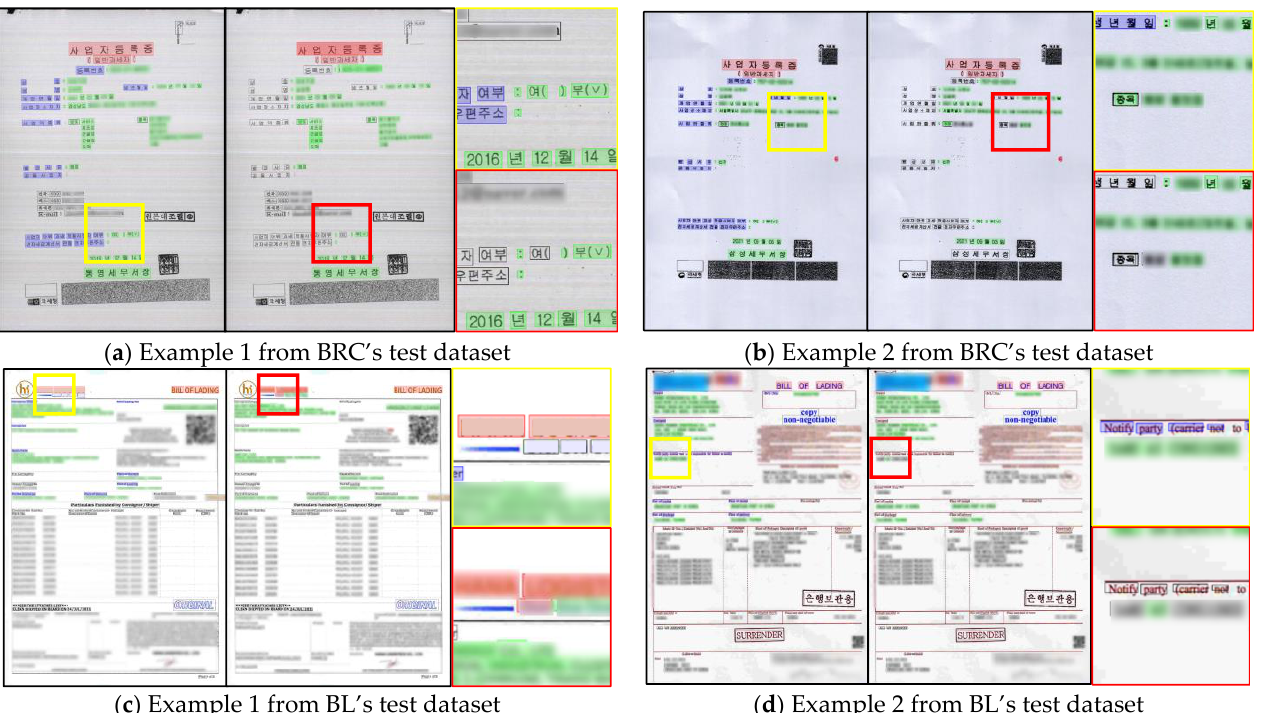
Figure 5. Examples of key information extraction results. Red, green, and blue text boxes represent the header, key, and value, respectively.